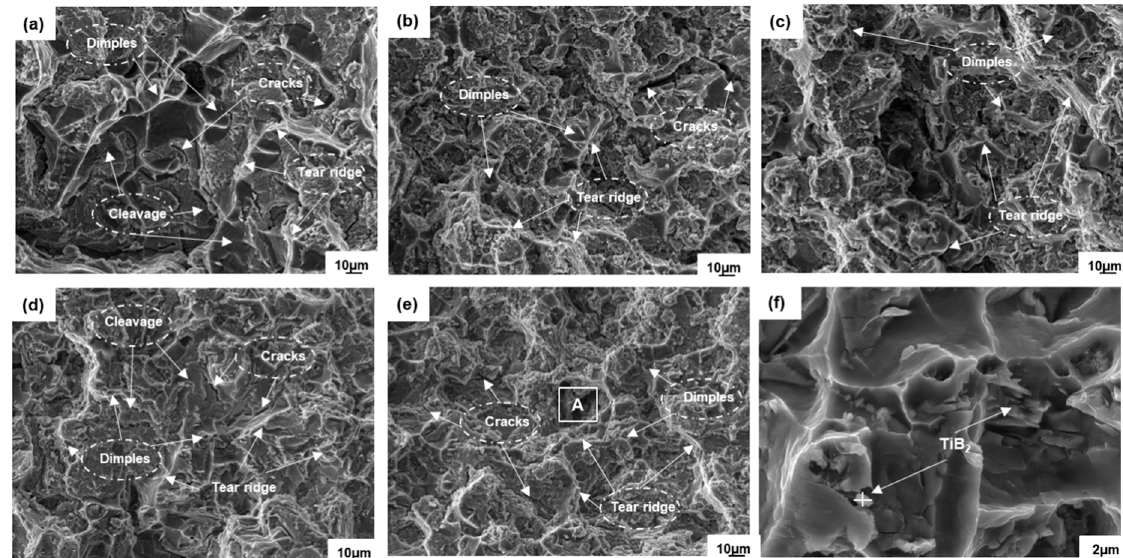
Figure 8. Tensile samples fracture surface morphology of ( a ) 2A14 alloy matrix, ( b ) TiB 2 / 2A14 composites without UVT, ( c ) TiB 2 / 2A14 composites with UVT for 30 s, ( d ) TiB 2 / 2A14 composites with UVT for 60 s, ( e ) TiB 2 / 2A14 composites with UVT for 120 s and ( f ) high magnification of A area.